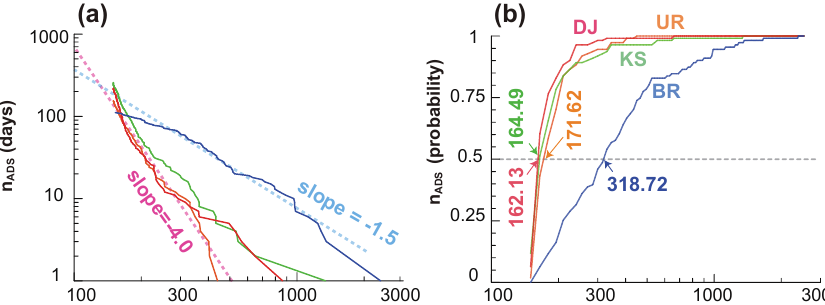
Figure 6. (a) Power-law fit to the ADS events as a function of PM 10 dust air concentration. The two reference lines are the maximum and minimum asymptotic power fitting with slopes of − 4.0 and − 1.5, respectively. (b) Cumulative distribution of PM 10 dust air concen- tration for the ADS data. Median values of PM 10 dust air concentration (PM 10median ) were 318.72µgm − 3 for BR, 162.13µgm − 3 for DJ, 164.49µgm − 3 for KS, and 171.62µgm − 3 for UR.